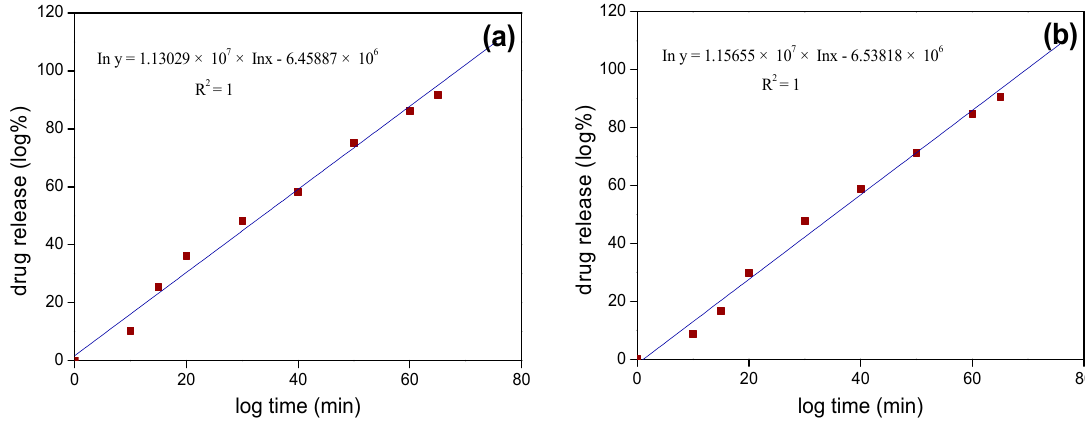
Figure 9. Drug release kinetic curves with Korsmeyer-Peppas model of ( a ) Fe 3 O 4 /SiO 2 core-shell composite nanospheres and ( b ) Fe 3 O 4 /SiO 2 /PPy core-shell composite nanospheres under